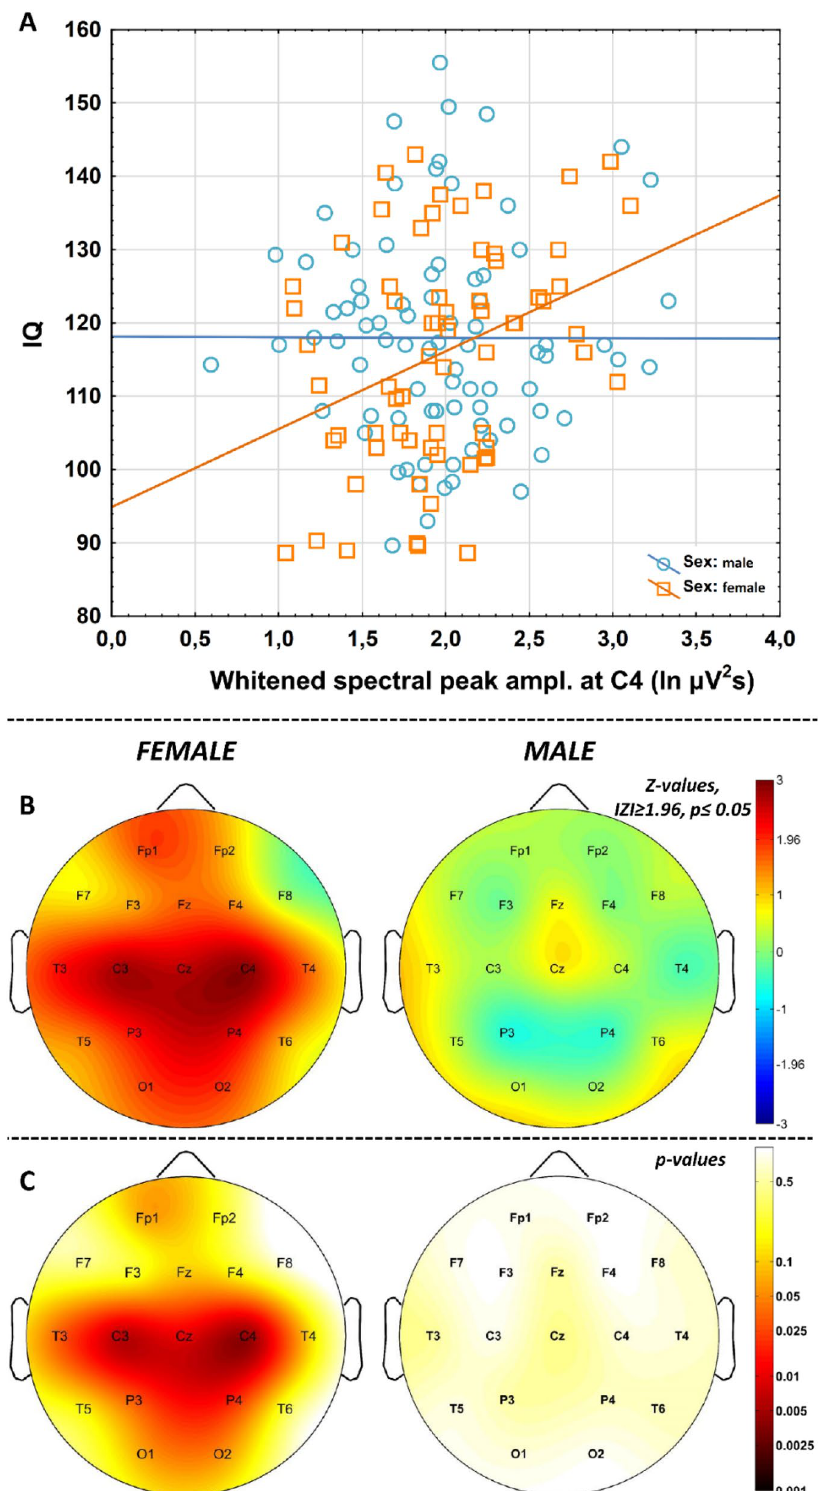
Figure 5. Correlations between NREM sleep EEG spindle frequency whitened spectral peak amplitudes and IQ in females and males. ( A ) Categorized scatterplot representing the correlation between whitened spectral peak amplitude of the NREM sleep EEG spindle frequency range (recording site: F4) and IQ in women and men. ( B Pearson r -values were transformed to Z -values and represented on topographical maps. C. Significance probability maps of the correlations presented in